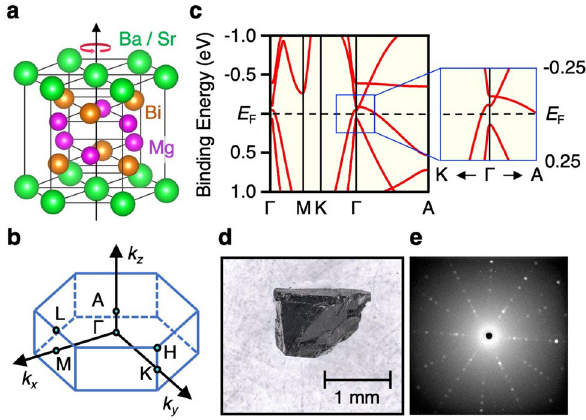
Figure 1. ( a , b ) Crystal structure and bulk hexagonal BZ of X Mg 2 Bi 2 ( X = Sr and Ba), respectively. ( c ) Calculated band structure of BaMg 2 Bi 2 along high-symmetry lines in bulk BZ obtained from the first-principles band- structure calculations, and its expanded view around the Dirac point (right panel). ( d ) Photograph of BaMg 2 Bi 2 single crystal. ( e ) X-ray Laue backscattering image of BaMg 2 Bi 2 obtained for the (0001)